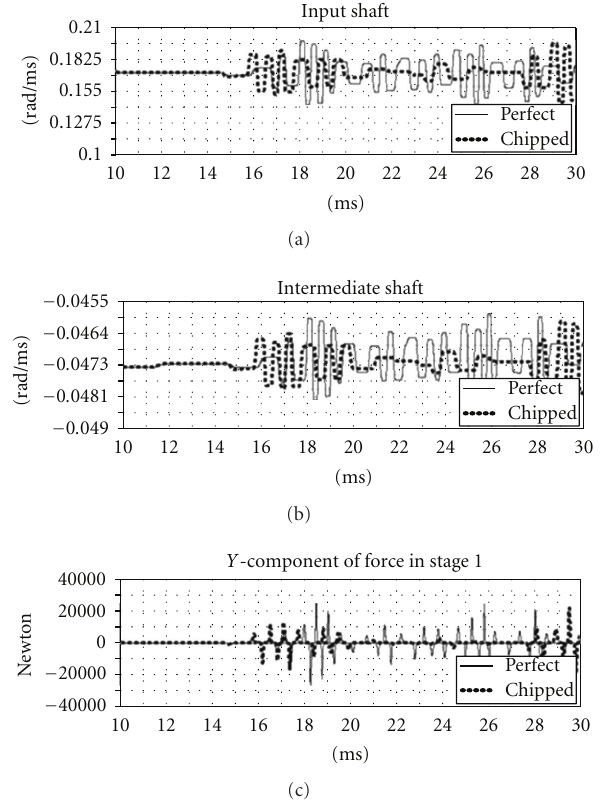
For the case with a chipped tooth on the input pinion, the entire curve is shifted forward in time. Although the impacts in Stage 1 occur earlier, the overall e ff ect in Stage 2 is delayed. The chipped tooth causes Stage 1 to become more excited, as a result it takes longer for the contact in Stage 2 to